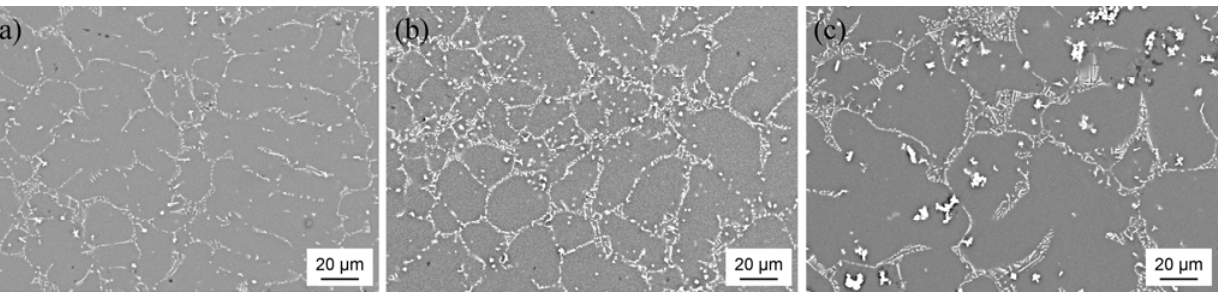
Figure 4. SEM images of the microstructures of binary Mg-Co alloys (RBSD mode):